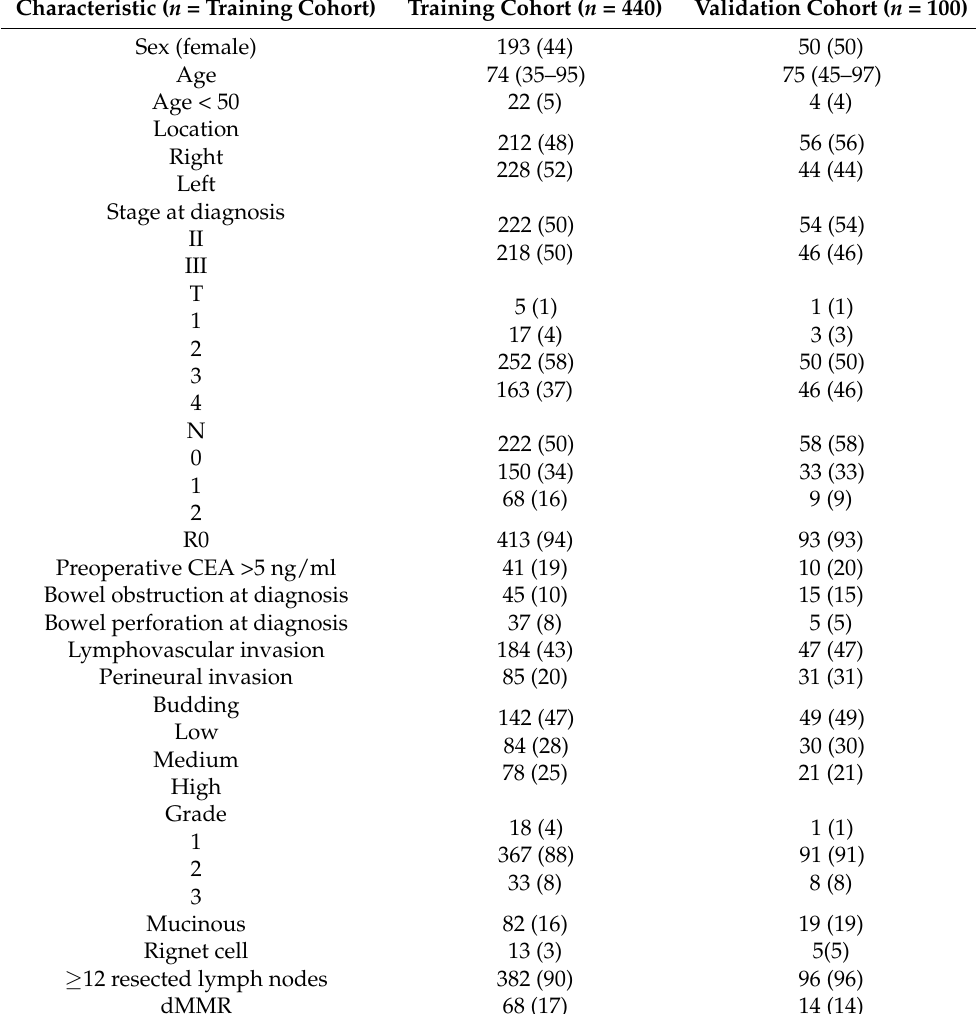
Table 1. Baseline characteristics of the patients.